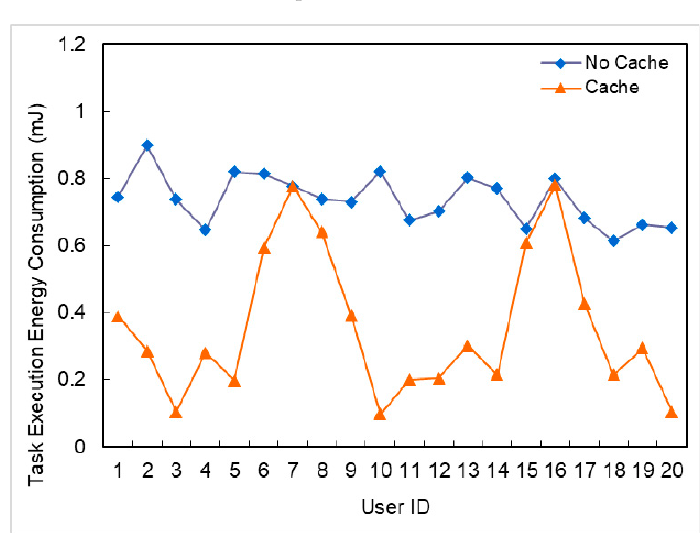
Figure 3. Task completion time for different users.